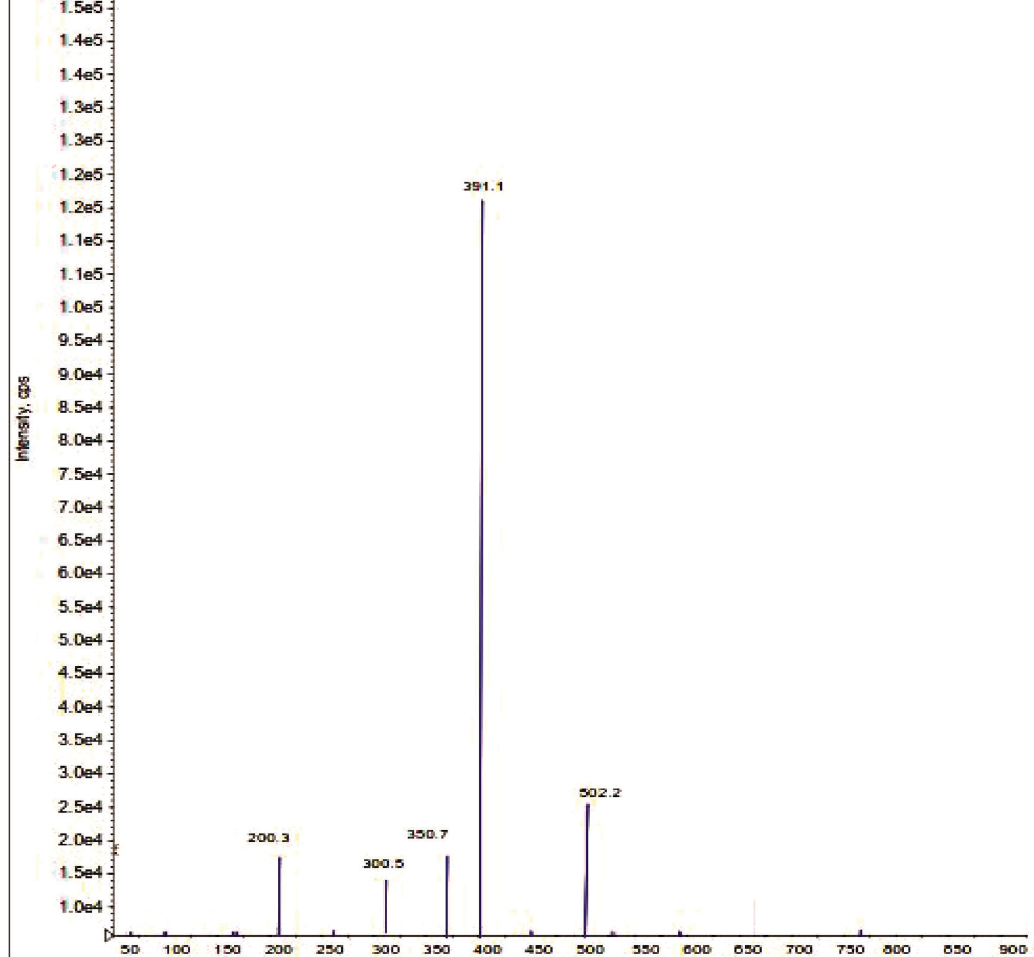
FIGURE 3 - Parent and product ion mass spectra of